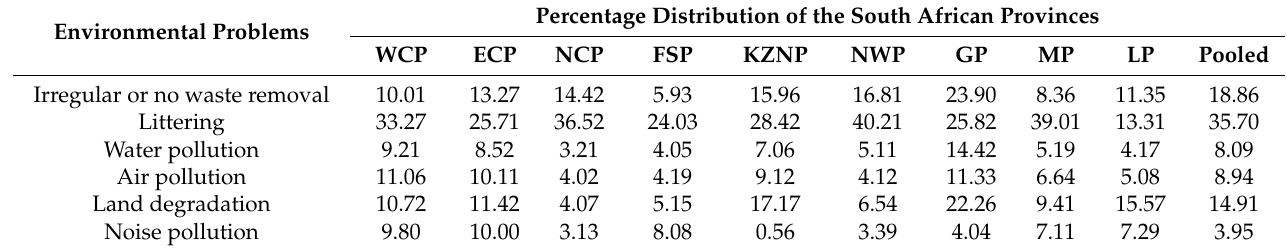
Table 3. Percentage distribution of environmental